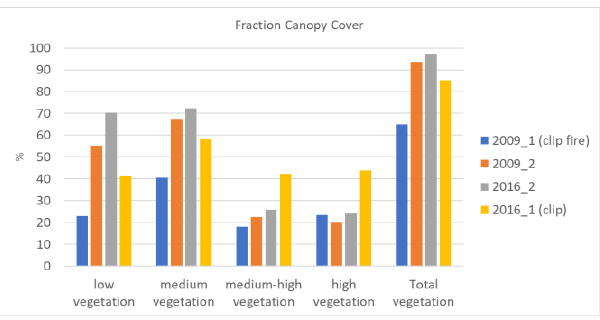
Figure 14. Fraction canopy